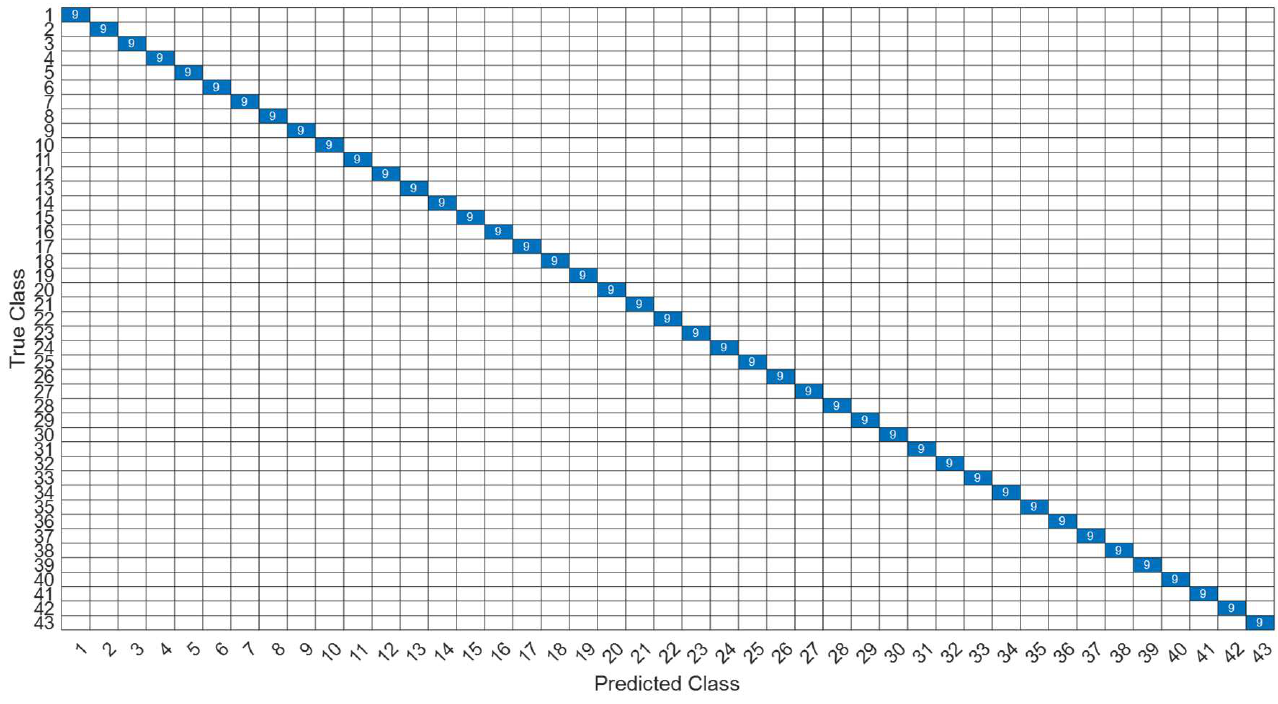
Figure 22. The confusion matrix of the LSTM model with LPC 30-features dataset.